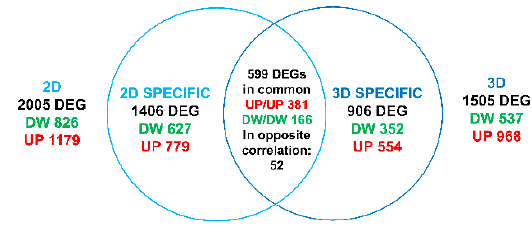
Figure 6. Comparison between the 2D and 3D datasets: Venn diagram of transcriptomic results comparing cystic fibrosis vs. normal human lung fibroblasts (CF-HLF vs. N-HLF) in 2D and 3D culture conditions.